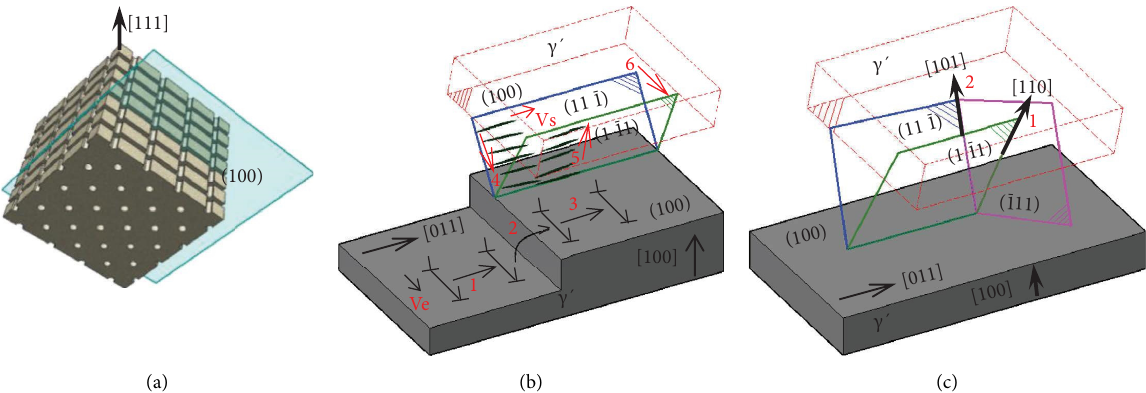
Figure 8: A schematic diagram of dislocation movement of the alloy during steady-state creep at 1040 ° C/137 MPa: (a) schematic diagram of c ′ phase lamellar rafting, (b) slip, cross slip, and climbing of dislocations, and (c) obstruction of the c ′ phase for the dislocation